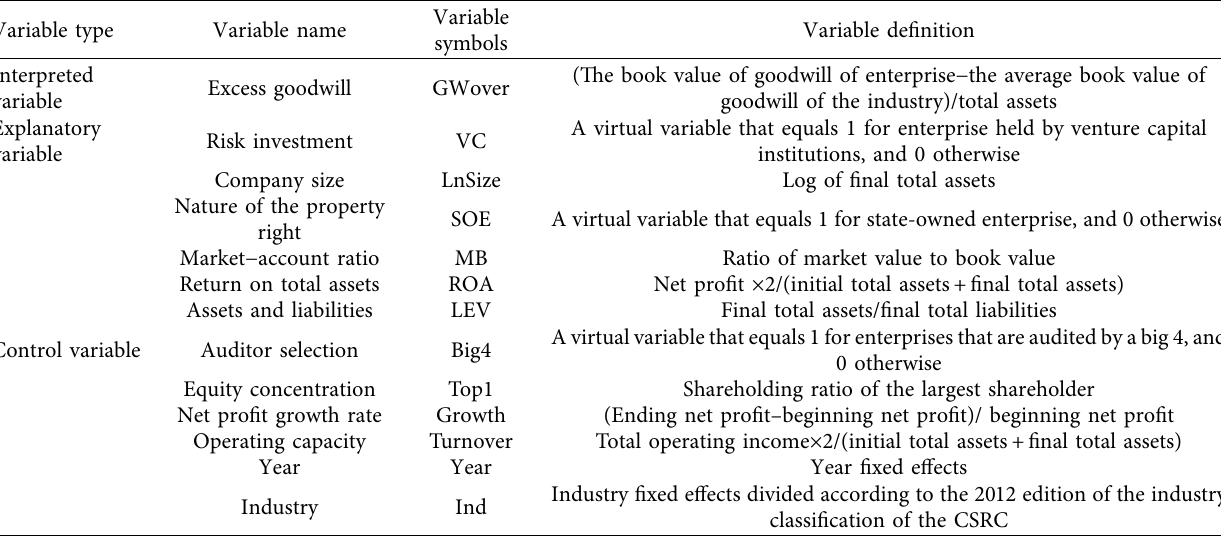
Table 1: Variable description and definition.